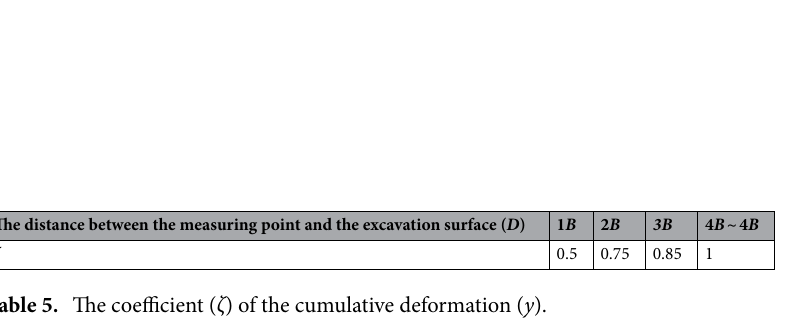
Table 5. The coefficient ( ζ ) of the cumulative deformation ( y